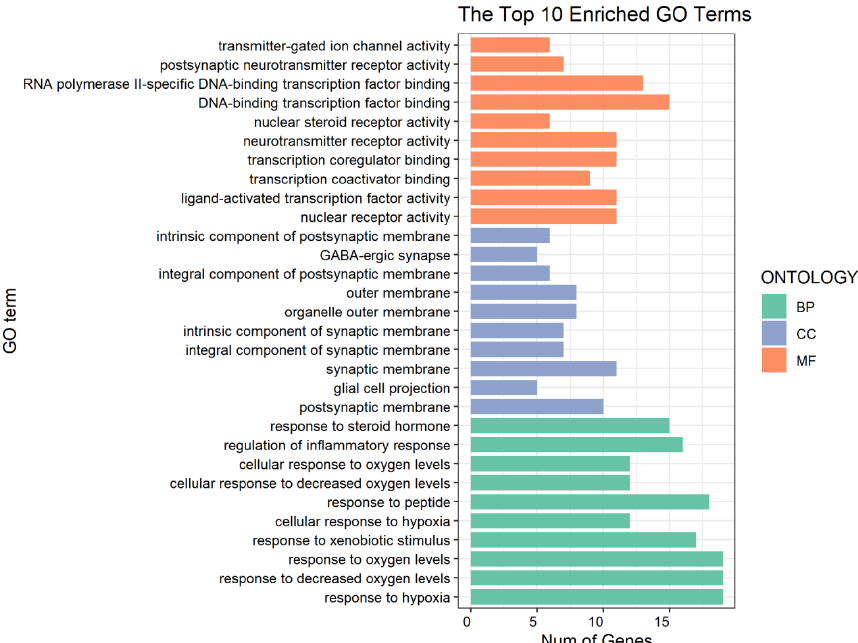
Figure 5. The top 10 enriched terms as shown in the GO enrichment. The x -axis represents the number of enriched genes in each term; the y -axis represents enriched terms in each category. BP: biological process; CC: cellular component; and MF: Molecular function.